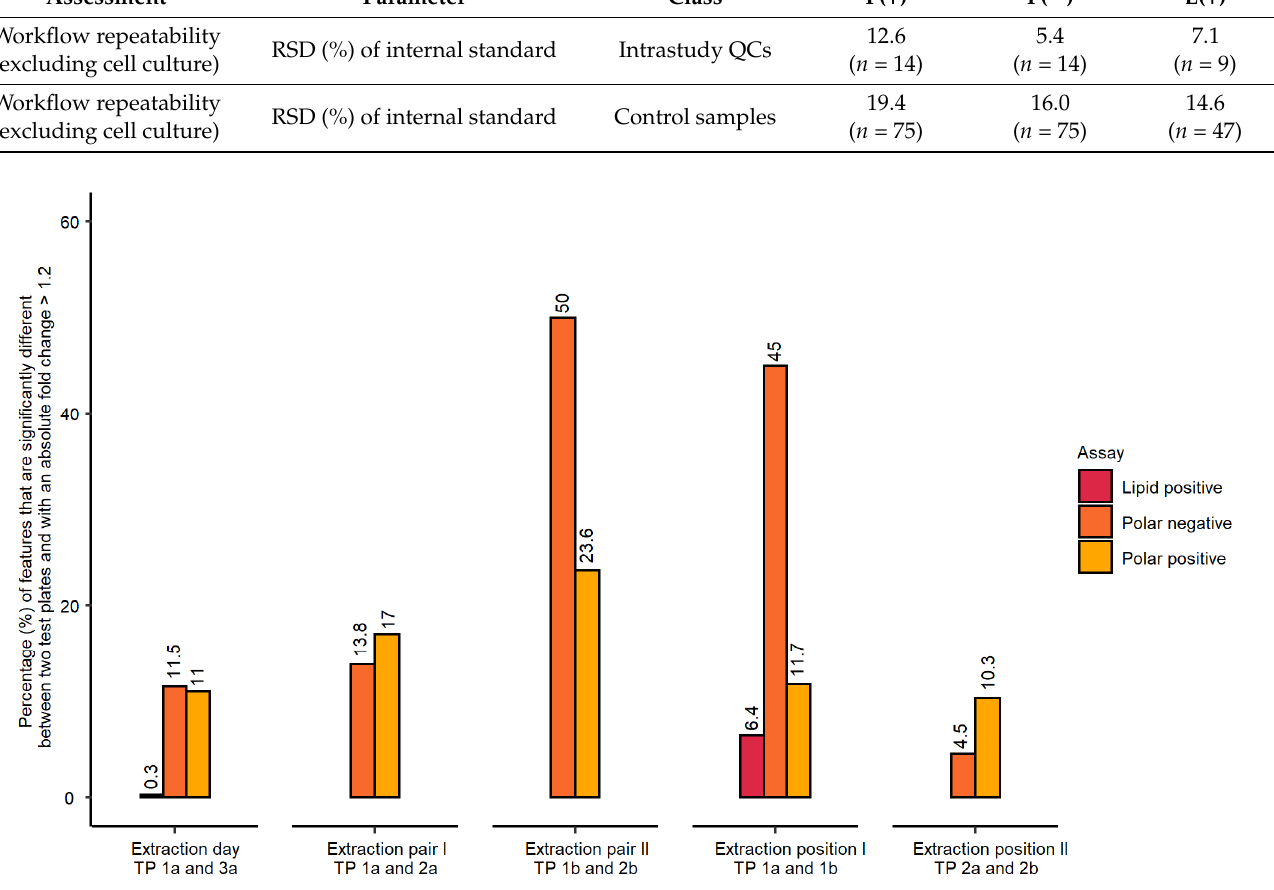
Figure 2. Percentage of metabolic features which were found “not repeatable” across studied experimental conditions measured for polar metabolites (both ionisation modes) and lipids (positive ionisation mode only). The order of extraction of 96-well microplates contributed most significantly to observed differences in feature intensities between the microplates, which triggered a modification of the proposed workflow.